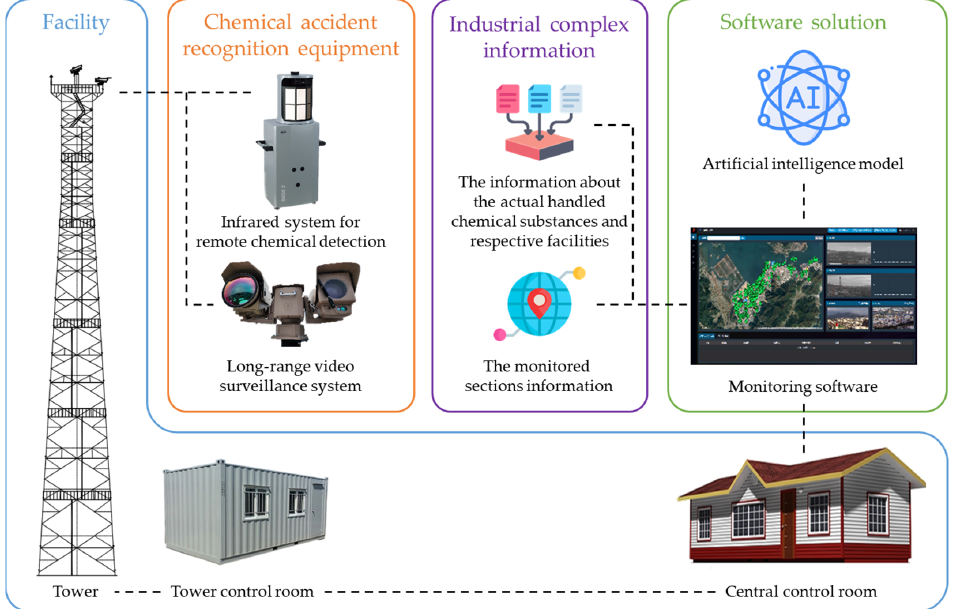
Figure 1. Overall configuration of the industrial complex chemical accident monitoring system.